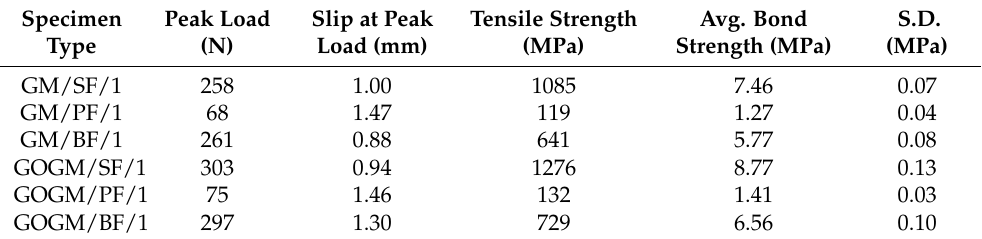
Table 7. Peak load and strength of fiber subjected 1 mm/s loading